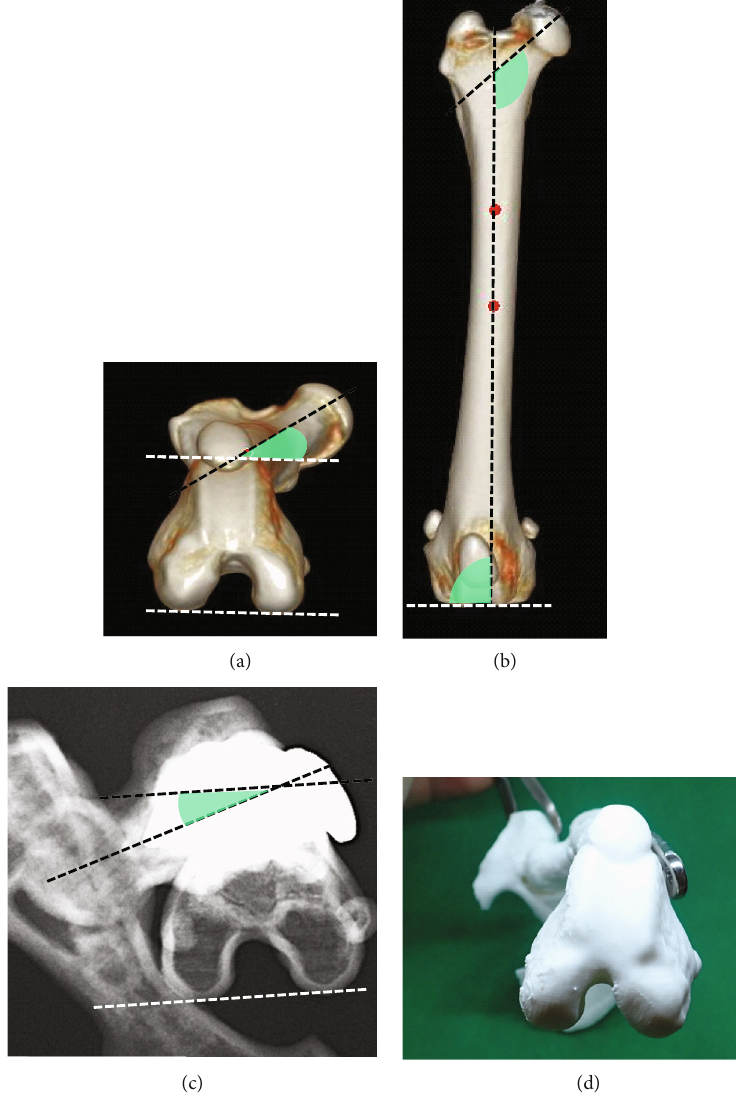
Figure 3: FTA, FIA, and aLDFA measurements in the una ff ected and a ff ected limbs with fractures. The una ff ected limb was evaluated using CT images. In addition, the a ff ected limb was assessed using radiographs of the model output using a 3-D printer. The a ff ected limb was fi xed with 42 ° external rotation compared to the una ff ected limb. (a) FTA measurements in the CT image of the una ff ected limb. (b) FIA and aLDFA measurements in the CT image of the una ff ected limb. (c) FTA measurements in radiographic images of a bone model that replicates a predicted previous surgery. (d) Photographs of bone models taken in the same direction as the radiograph. FTA: femoral torsion angle; FIA: femoral inclination angle; aLDFA: anatomical lateral distal femoral angle; CT: computed